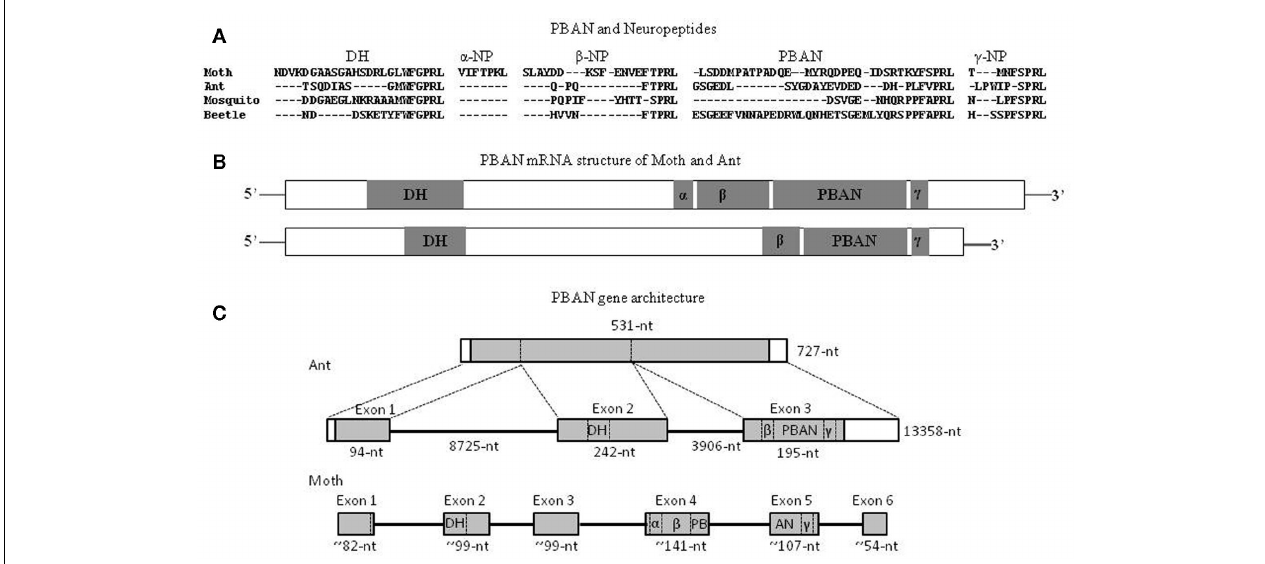
species. DH, diapause hormone homolog; α , β , and γ : neuropeptides encoded from the cDNA; PBANs are translated from exon 3 in ants, and exons 4 and 5 in moths, respectively.The shaded area represents PBAN coding regions. Open areas represent untranslated regions.The alignment was made with Genetyx-Tree software (ver. 10; Choi andVander Meer, 2009; Choi et al., 2011).